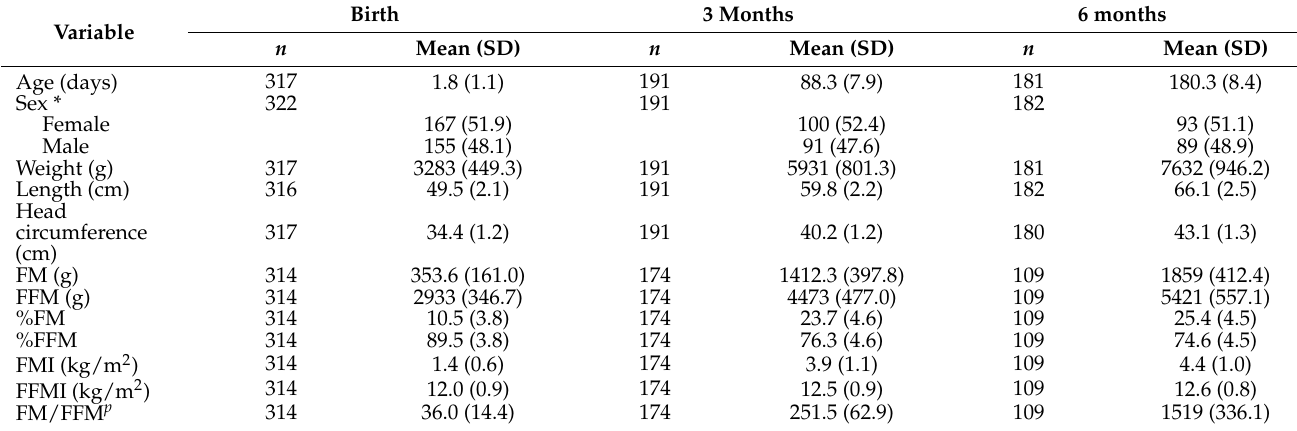
Table 2. Characteristics of infants at birth, 3 months and 6